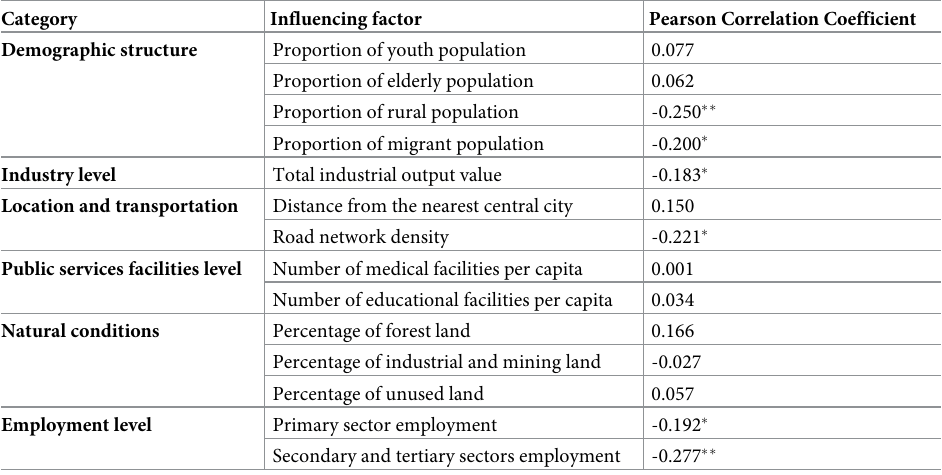
Table 2. Pearson correlation coefficient between small towns shrinkage and its influencing